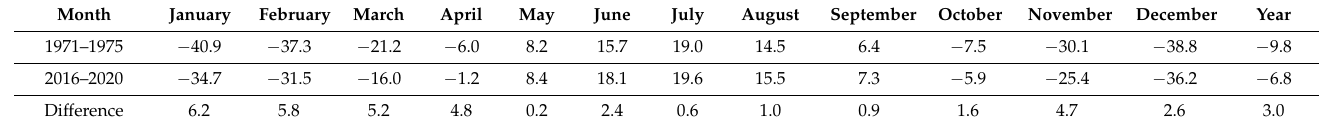
Figure 9. Change in depth of the mean annual ground temperature at the Tuymaada Station. Table 4. Average monthly and mean annual air temperature for certain periods in Yakutsk ( ◦ C).